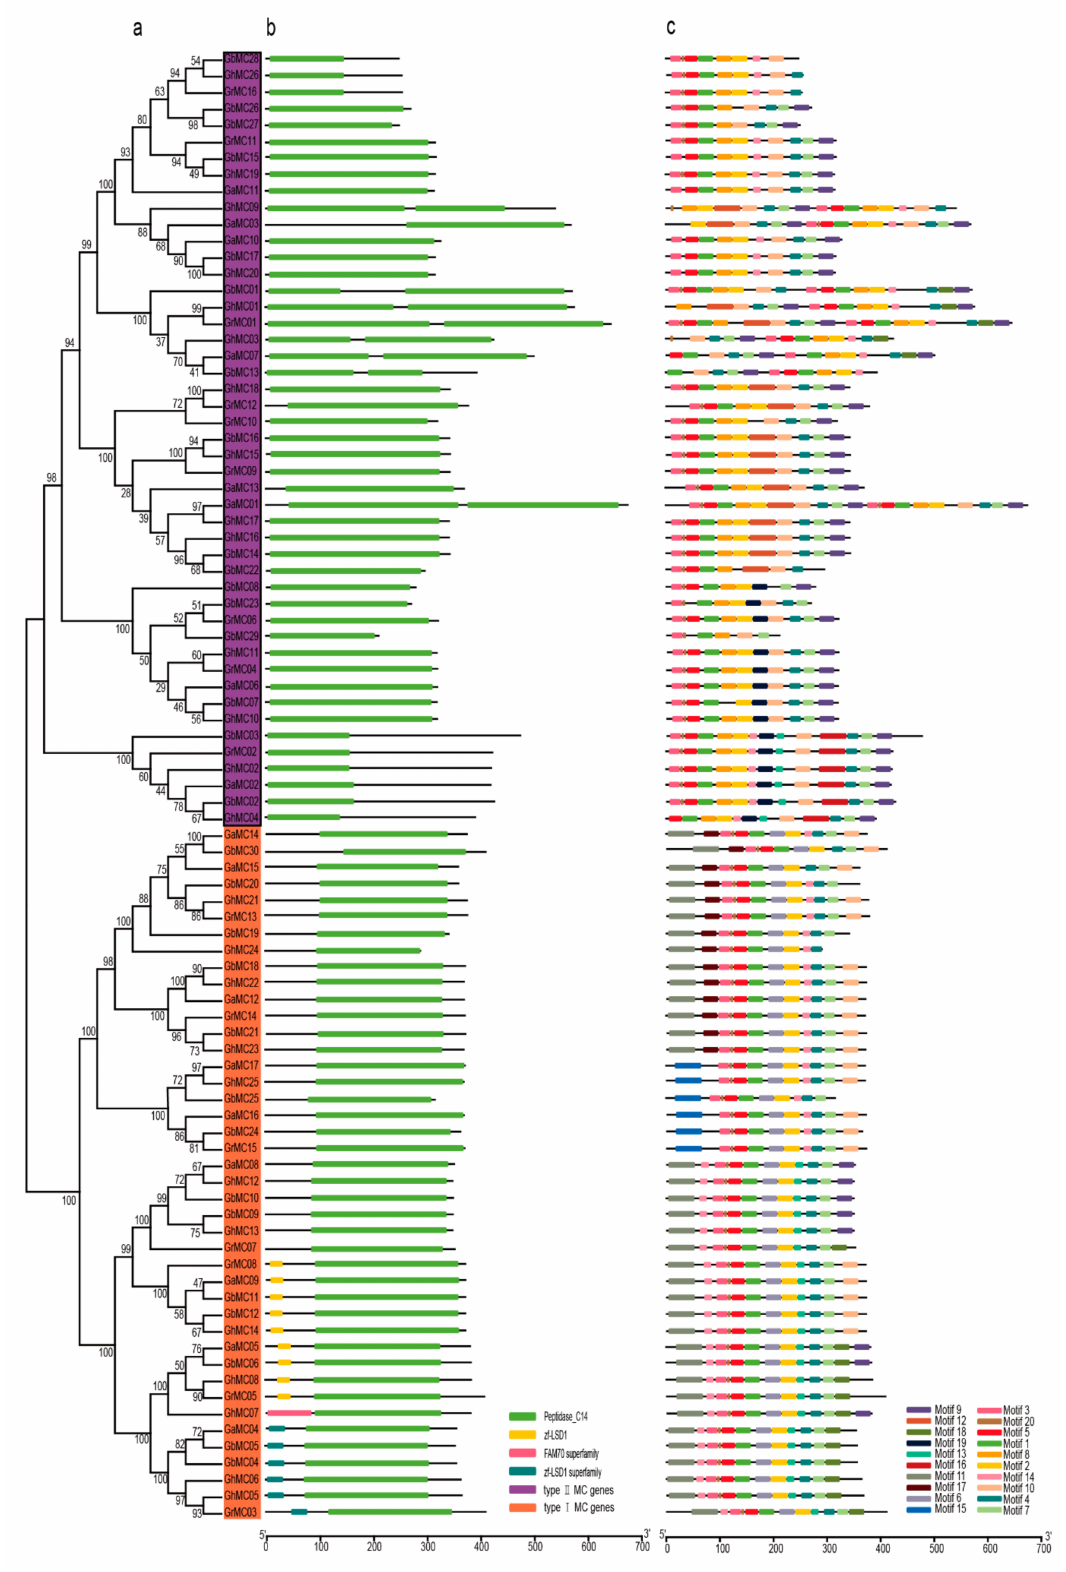
Figure 2. The stucture analysis of metacaspase gene family. ( a ) Phylogenetic tree of the metacaspase (MC) gene family. ( b ) Analysis of the protein sequences of the MC gene family domains. ( c ) Analysis of the protein sequences of the MC gene family